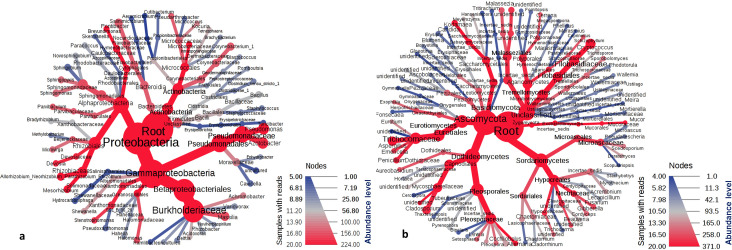
Taxonomic distribution of microbial populations associated with dust aerosols in Kuwait, (a) Bacterial; (b) Fungal. A differential heat tree was plotted to depict the commonly abundant taxa in terms of relative abundance. The nodes in red highlight the constantly detected genera, families, orders, classes and phyla.